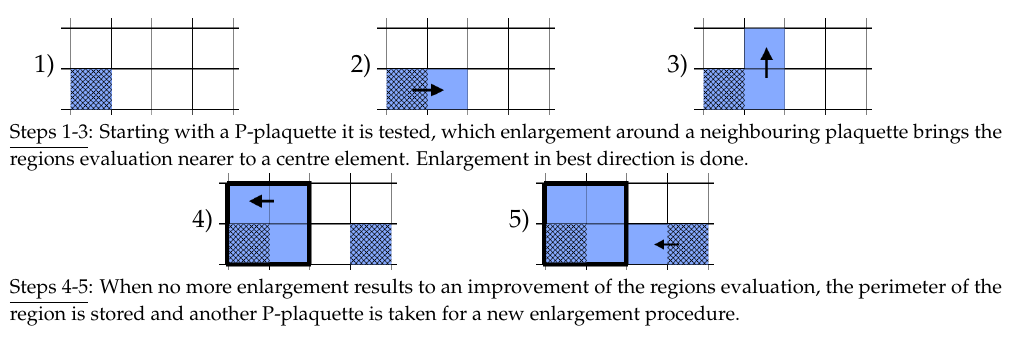
Figure 3. Thick vortex piercings are identified by detecting non-trivial center regions around P-plaquettes, plaquettes pierced by